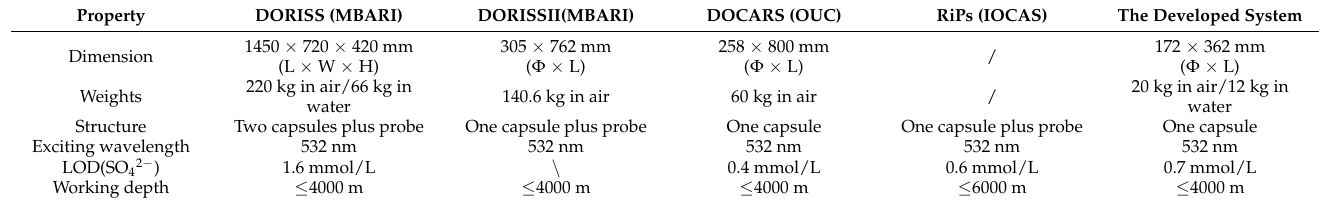
Table 2. The parameters of the developed system in comparison with the reported underwater Raman system. Property